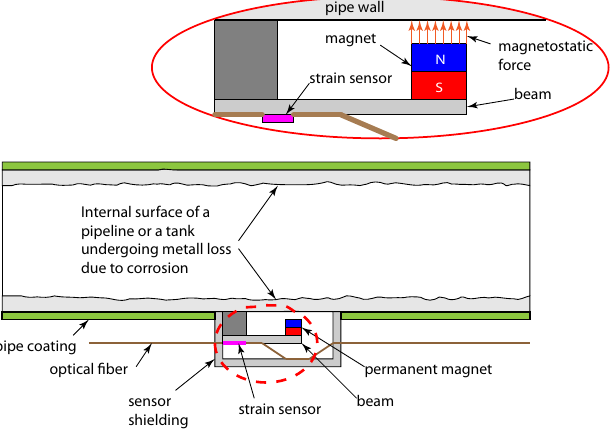
Figure 1. Initial schematic of proposed sensing